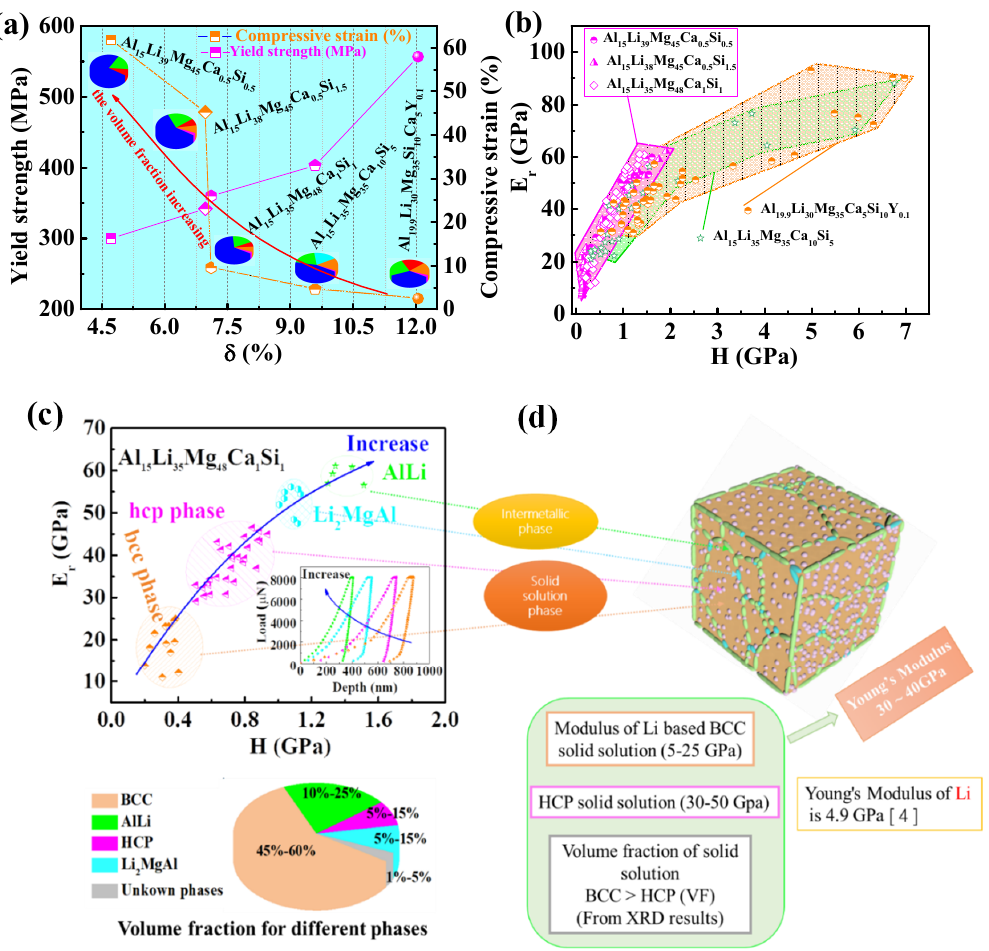
Figure 7. ( a ) Relationship between yield strength, compressive strain, volume fractions of solid-solution phases and δ (%). ( b ) Young’s modulus as a function of hardness for five ULW-CCAs. ( c ) The relationship between Young’s modulus and hardness for different solid-solution phases and intermetallic compounds. ( d ) Structure model of the Al 15 Li 35 Mg 48 Ca 1 Si 1 ULW-CCA. The specific strength vs. Young’s modulus of different alloys is represented in Figure